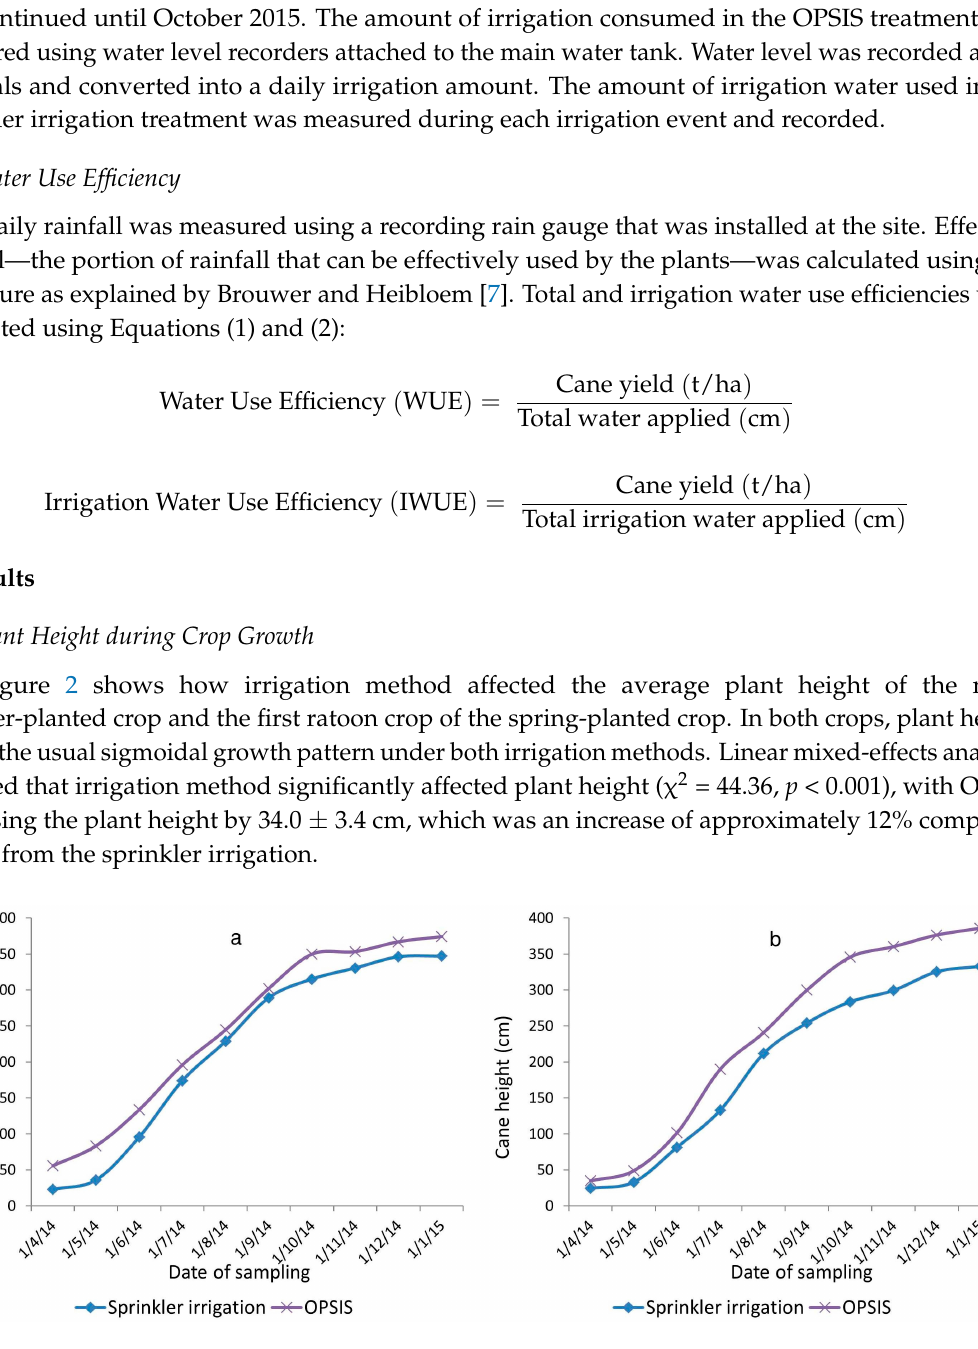
Figure 2. Average plant height of sugarcane cultivar Ni21 as affected by irrigation method in ( a ) the summer-planted main crop and ( b ) the first ratoon crop of spring-planted sugarcane.